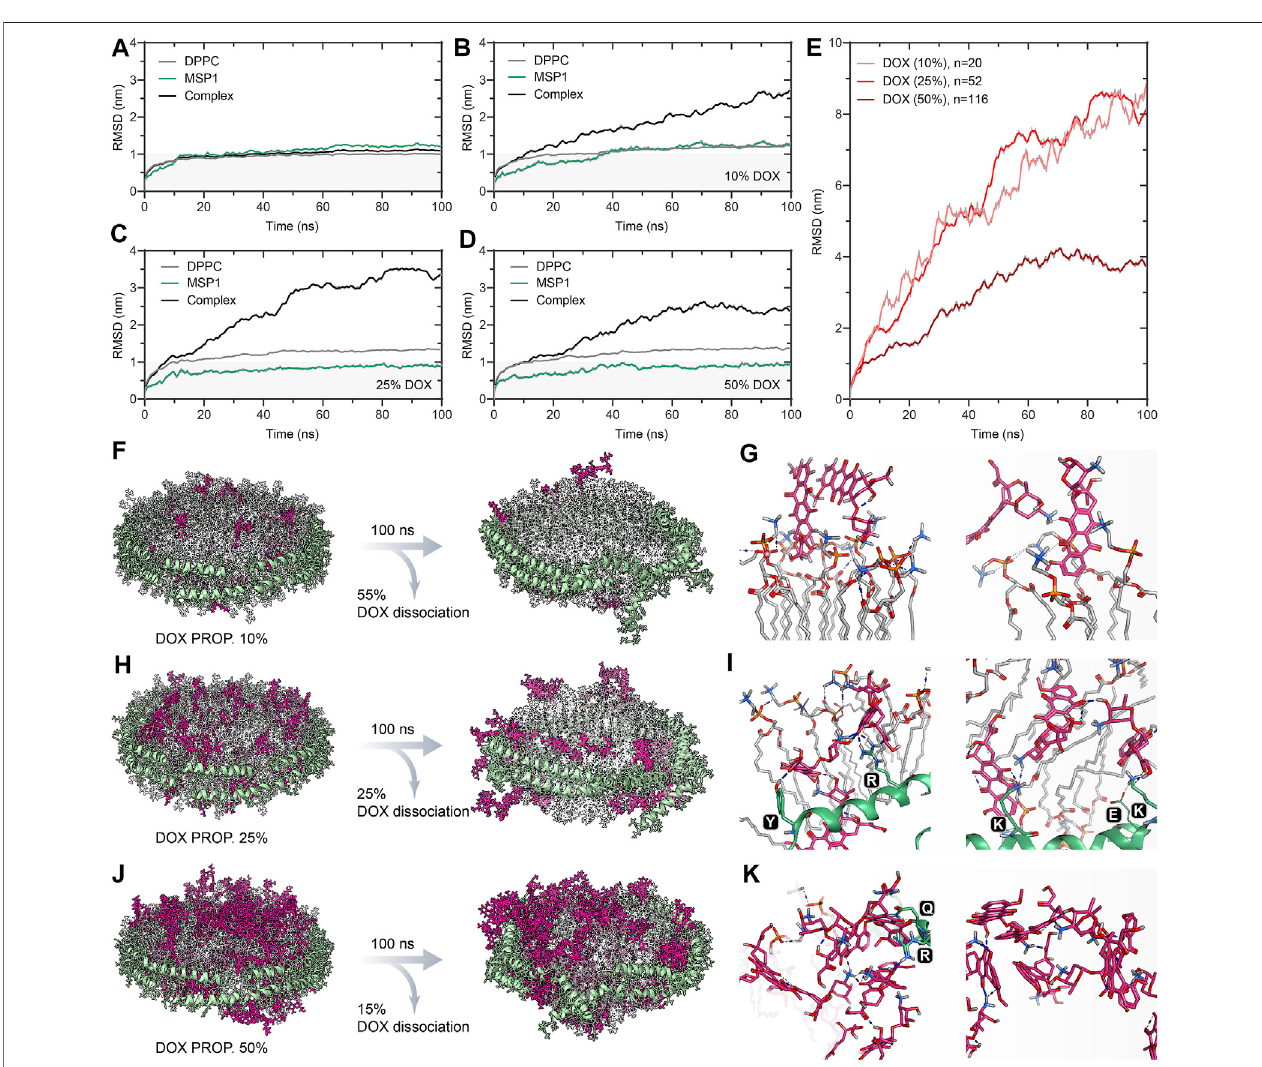
FIGURE 3 | RMSD trajectories and snapshots of center clusters for various types of lipidated-DOX prodrug ND formulations with increasing drug proportions (10, 25, and 50%). (A) ND formulation of DOX-BMPH-PTE. (B) ND formulation of DOX-BMPH-MP. (C) ND formulation of DOX-BMPH-TC.